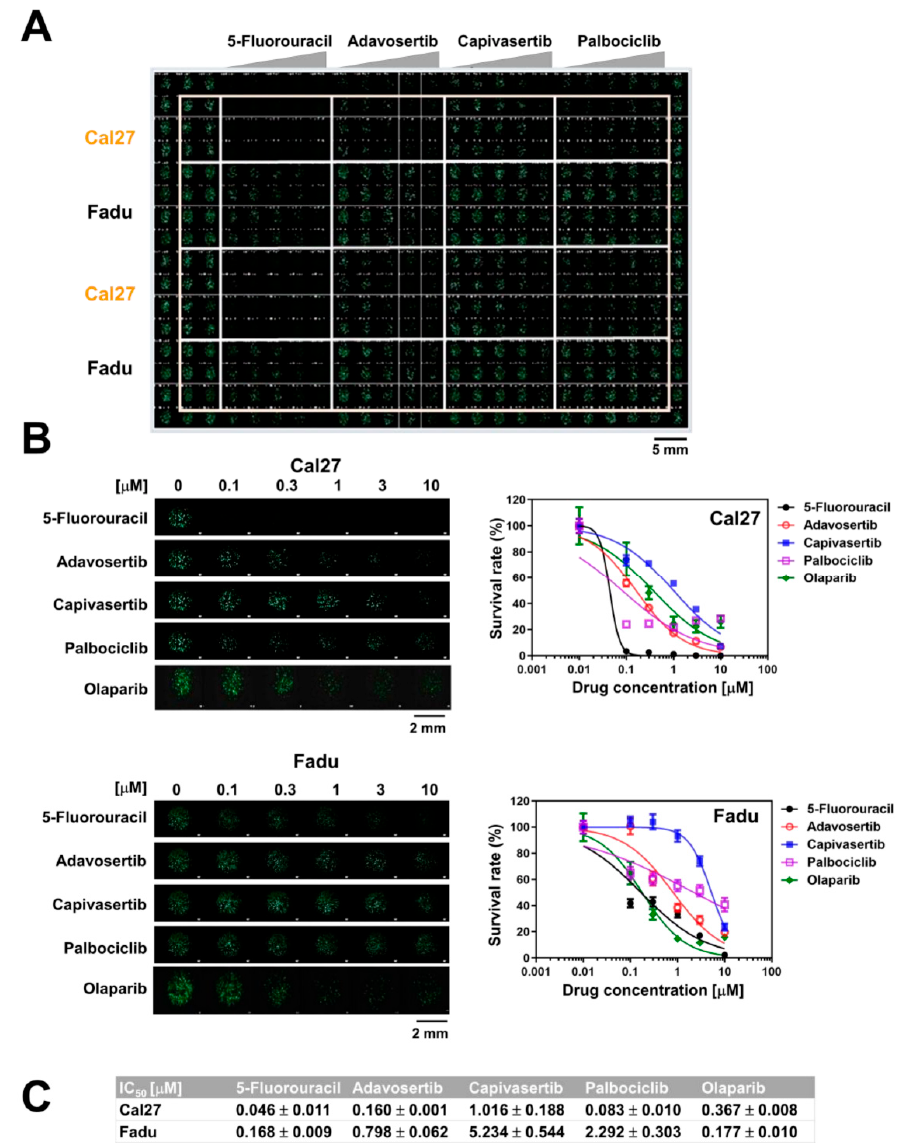
Figure 4. Measurement of the drug sensitivity in HNSCC spheroids using the 3D-based HTS plat- form. ( A ) Layout of a 384-pillar/well plate containing Cal27 and Fadu spheroids for different drug treatments. Representative fluorescence image was captured after 7 days of incubation with drugs. ( B ) Comparison of sensitivity of Cal27 and Fadu spheroids in response to five anticancer drugs at the indicated concentrations. Left, representative fluorescent images of Cal27 and Fadu spheroids showing different responses to the drugs. Right, Dose–response curves of Cal27 and Fadu spheroids. ( C ) IC 50 values of five anticancer drugs on Cal27 and Fadu spheroids. Data are mean ± S.D. ( n = 7) from two independent experiments.